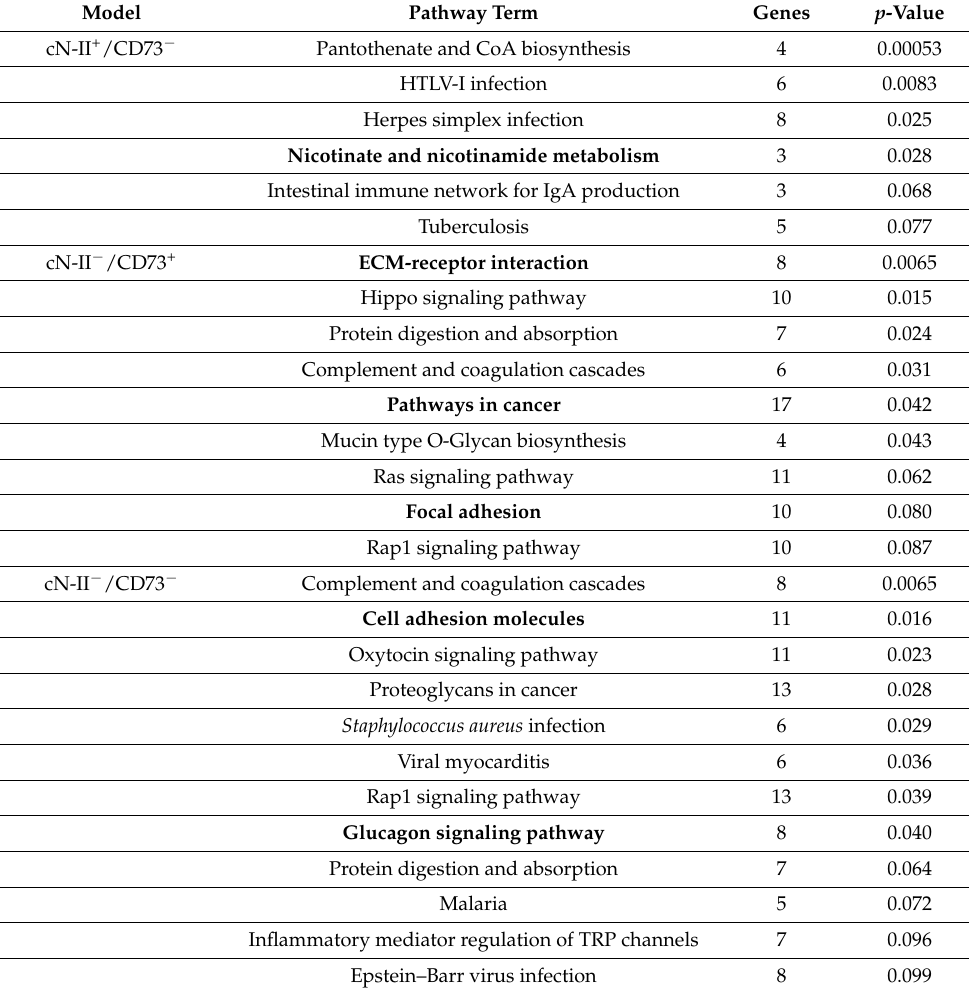
Table 3. Conservative pathway analysis of RNA sequencing data. The table indicates pathways with p < 0.1 with a cutoff of 2-fold change in expression levels. In bold: pathways detailed in Supplementary Table